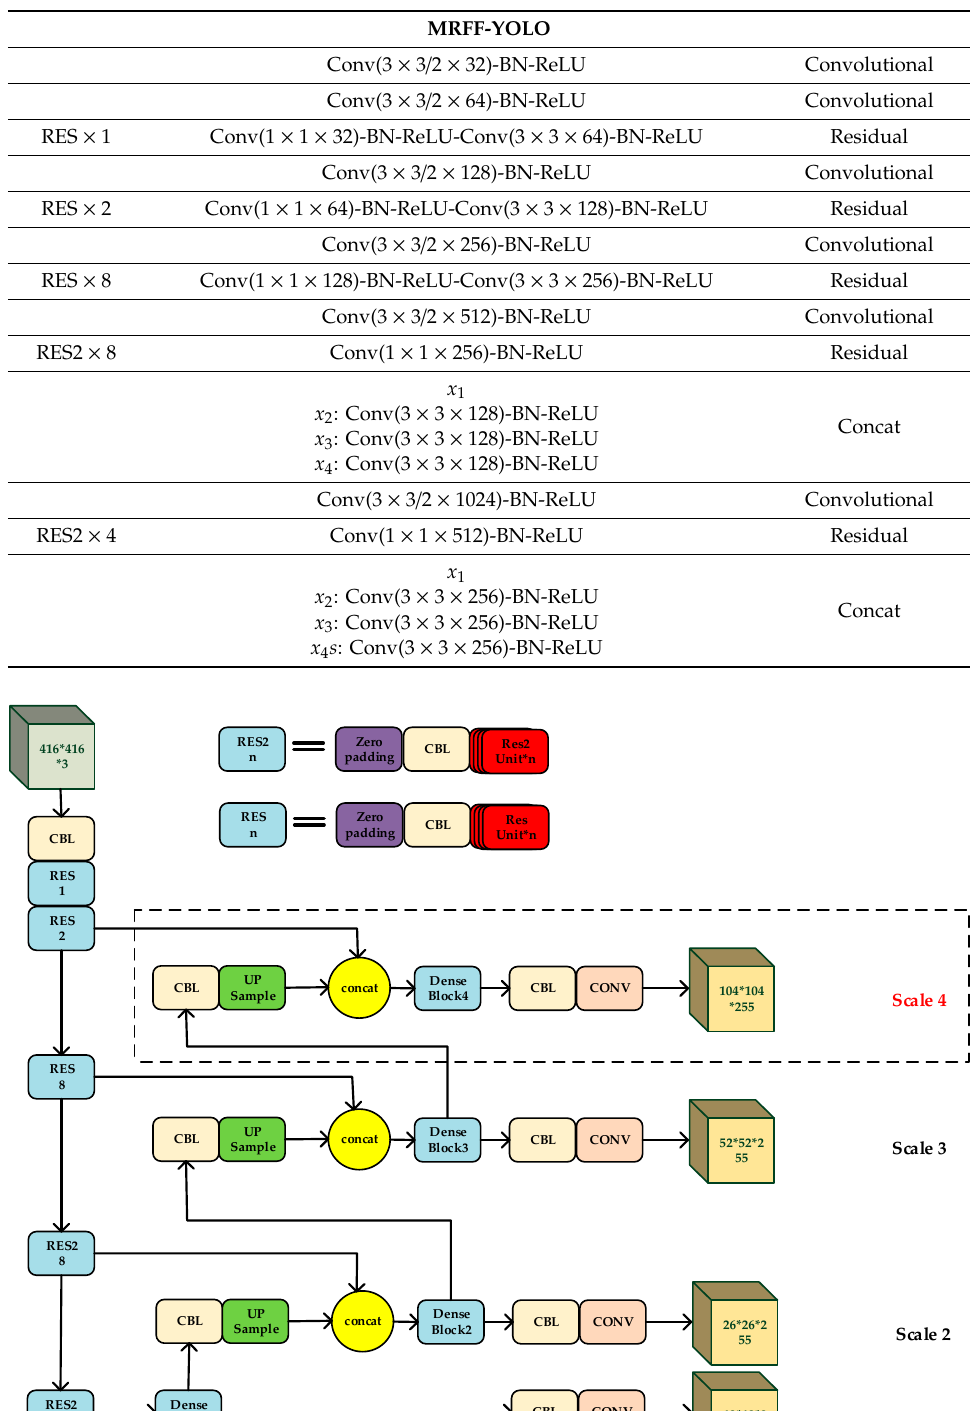
Table 2. The parameter setting of the feature extraction network of Multi-Receptive Fields Fusion YOLO (MRFF-YOLO).